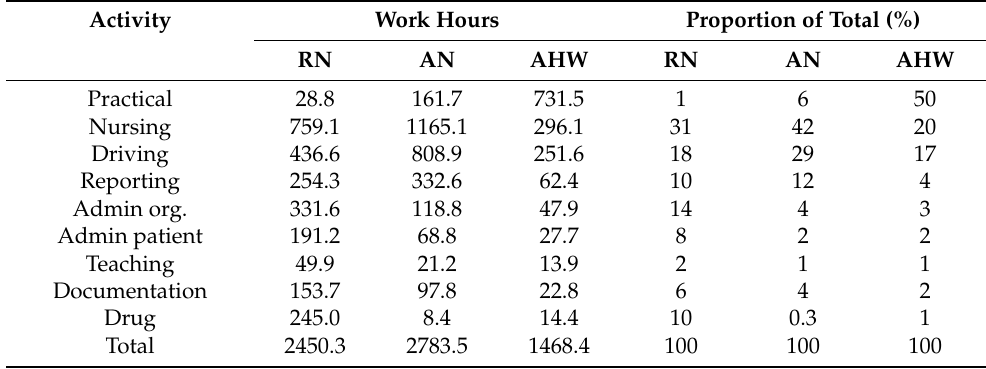
Table 3. The number and proportions of work hours by activity and staff